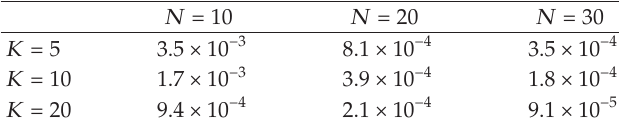
Table 7: Maximum absolute errors for α (cid:8) 1 . 75 for Example